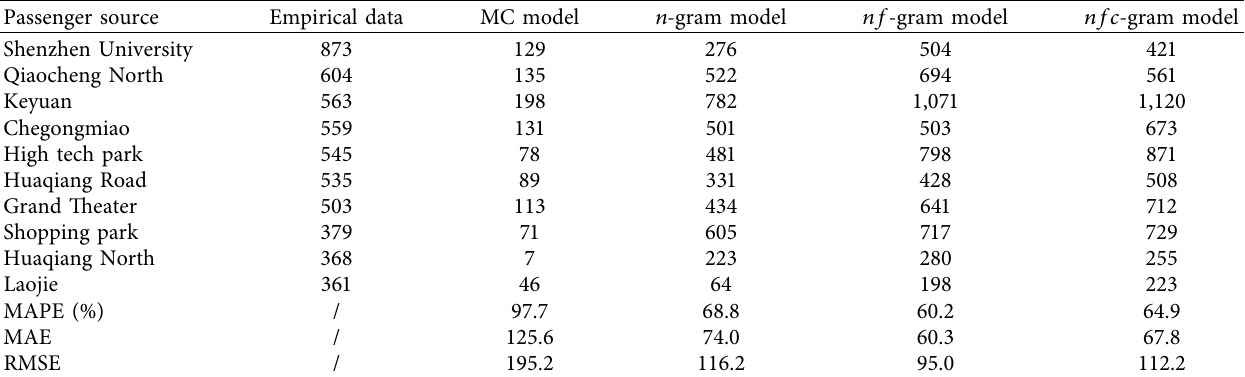
Table 5: The number of event participants from the main passenger sources of crowding station from 6:00 p.m. to 7:00 p.m. Passenger